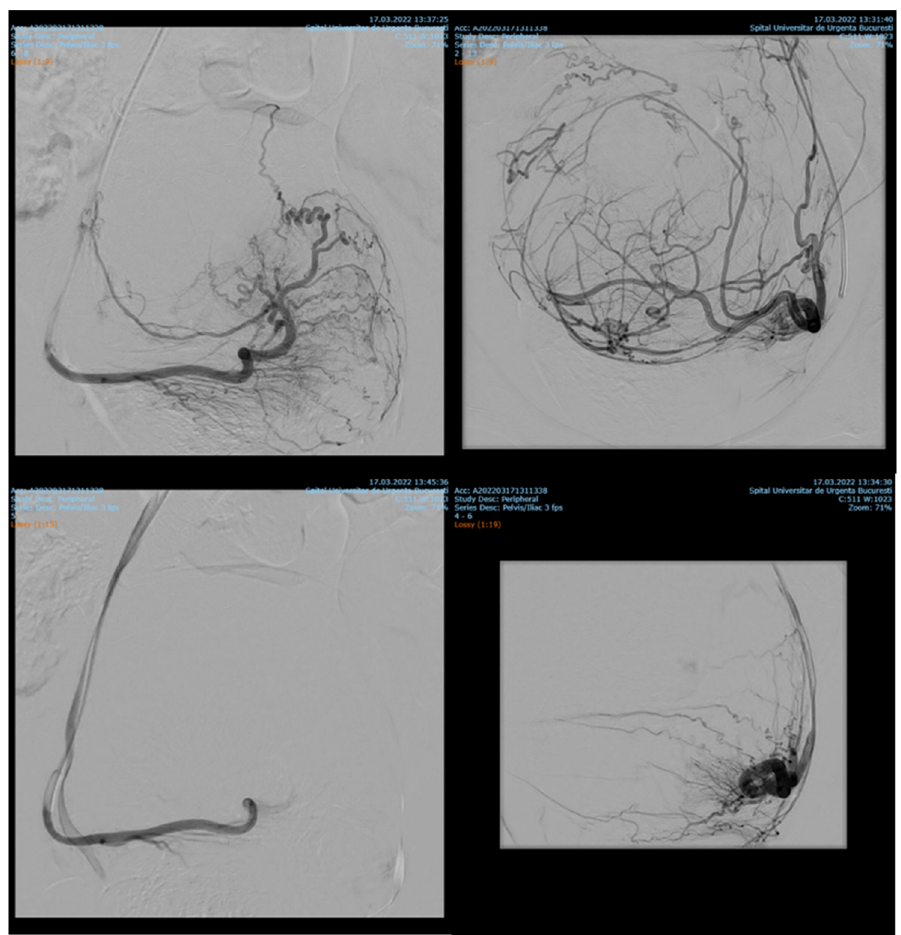
Figure 1. Uterine artery embolization in uterine leiomyoma. 7.84% (n = 89) of the patients with cervix cancer needed supraselective embolization of cervicovaginal and long vaginal arteries, as seen in Figures 2 and